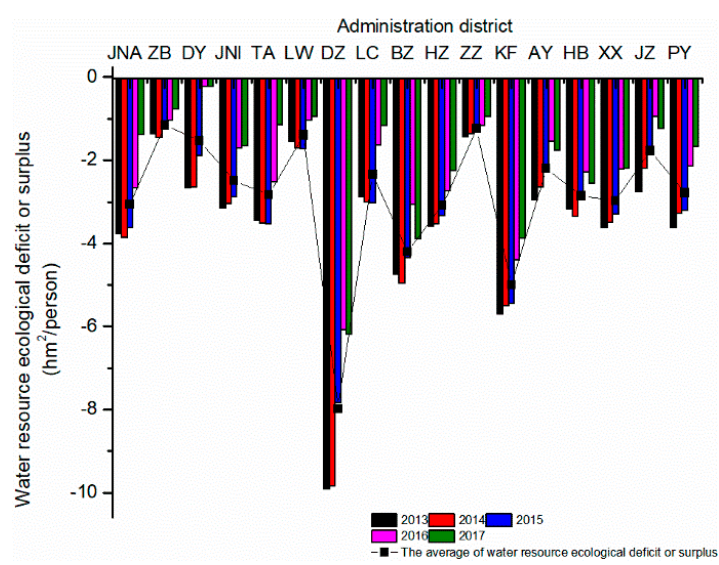
Figure 9. Water resources ecological deficit or surplus in the lower reaches of the Yellow River in 2013–2017.